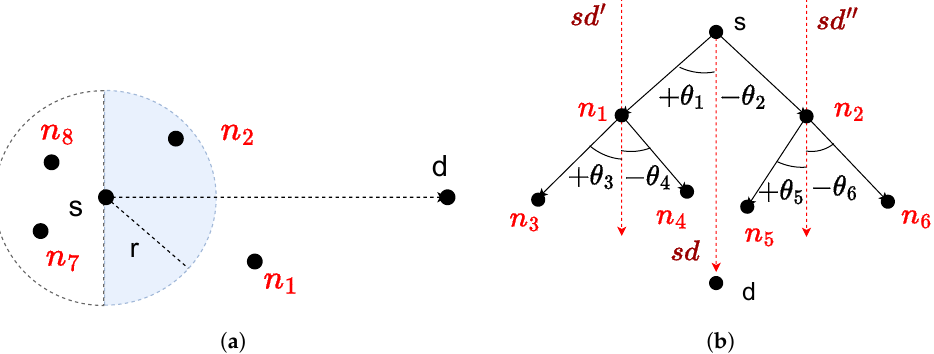
Figure 1. ( a ) Front-side scanning with respect to a destination node, and ( b ) geometric angle formation at one- and two-hop